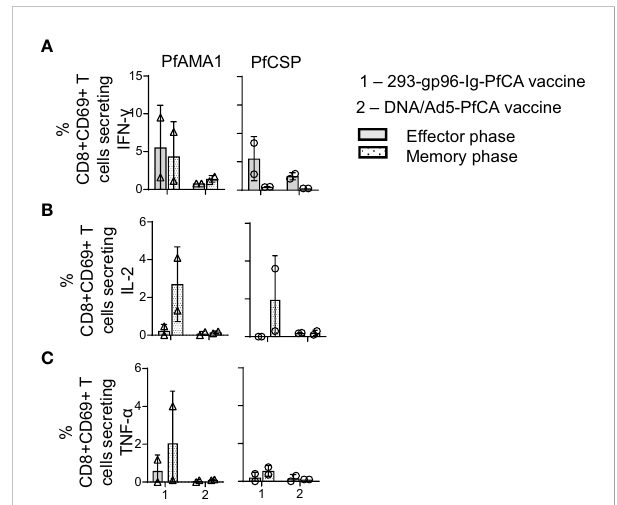
FIGURE 6 293-gp96-Ig-PfCA vaccine induces antigen-speci fi c, intrahepatic memory CD8+ T cells secreting IL-2. Characterization of PfAMA1 and PfCSP-speci fi c, cytokine responses by intrahepatic memory CD8+ T cell in rhesus macaques at effector (1 week, n=2) and memory (11 weeks, n=2) time-points following the third dose of the 293-gp96-Ig-PfCA vaccine. Control animals received DNA/Ad5- PfCA vaccine and sacri fi ced at effector (3 weeks, n=2) and memory (11 weeks, n=2) time-points following the Ad5 boost. Peripheral blood mononuclear cells (PBMCs) and intrahepatic lymphocytes were stimulated with PfCSP and PfAMA1 overlapping peptides for 18h and intracellular expression of (A) IFN- g (B) IL-2 and (C) TNF-